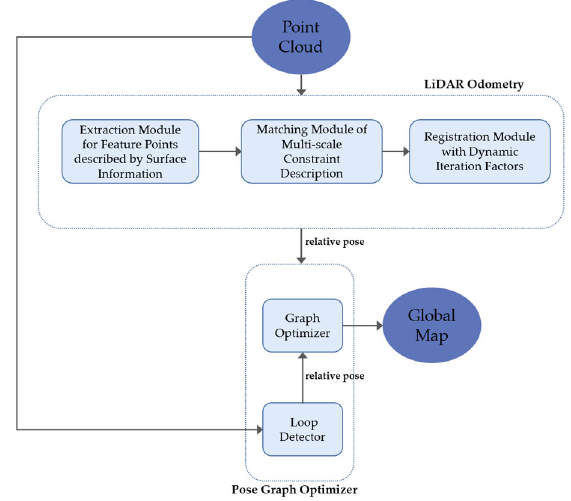
Figure 3. Algorithm overview.